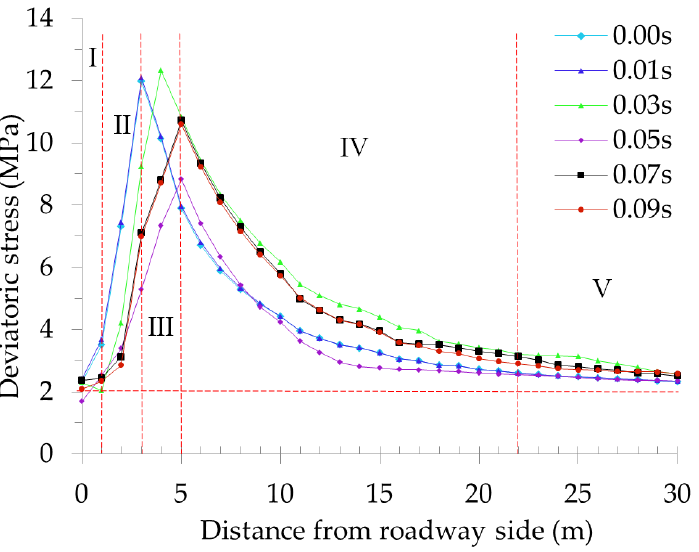
Figure 4. Dynamic Evolution Curves of Maximum Principal Deviatoric Stress in Surrounding Rock of Roadway under Dynamic Load Disturbance. ( Ⅰ –broken zone; II– original plastic zone; III– newly added plastic zone; IV –elastic zone; V– stress zone of primary rock ) .